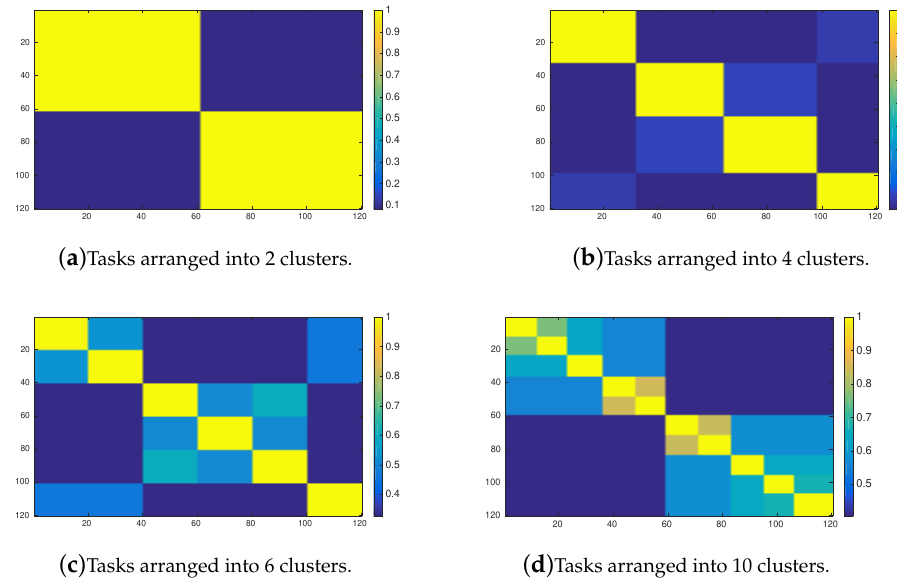
( c ) Tasks arranged into 6 clusters. ( d ) Tasks arranged into 10 clusters. Figure 12. Possibilistic transition matrix, induced by the OPRF, powered after reaching a stationary possibilistic distribution ( P τ ) for the 120 tasks, nTH = 4 and different number of clusters of